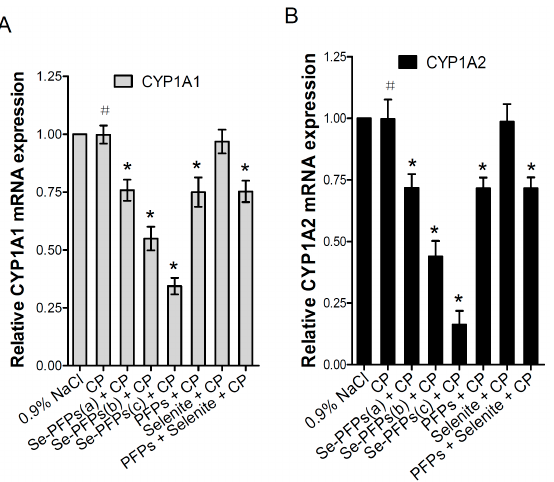
Figure 1. Effects of administration of Se-PFPs, PFPs, selenite, and PFPs + selenite on relative mRNA expression levels of: CYP1A1 ( A ); and CYP1A2 ( B ) relative to GAPDH in liver microsomes of mice examined by RT-PCR. All the values are shown as means ± SD ( n = 10). # p > 0.05, compared with 0.9% NaCl; * p < 0.05, compared with CP. PFPs, polysaccharide from P. fortuneana , Se-PFPs, polysaccharides from Se-enriched P. fortuneana , and PFPs + selenite, the combination of PFPs and selenite.